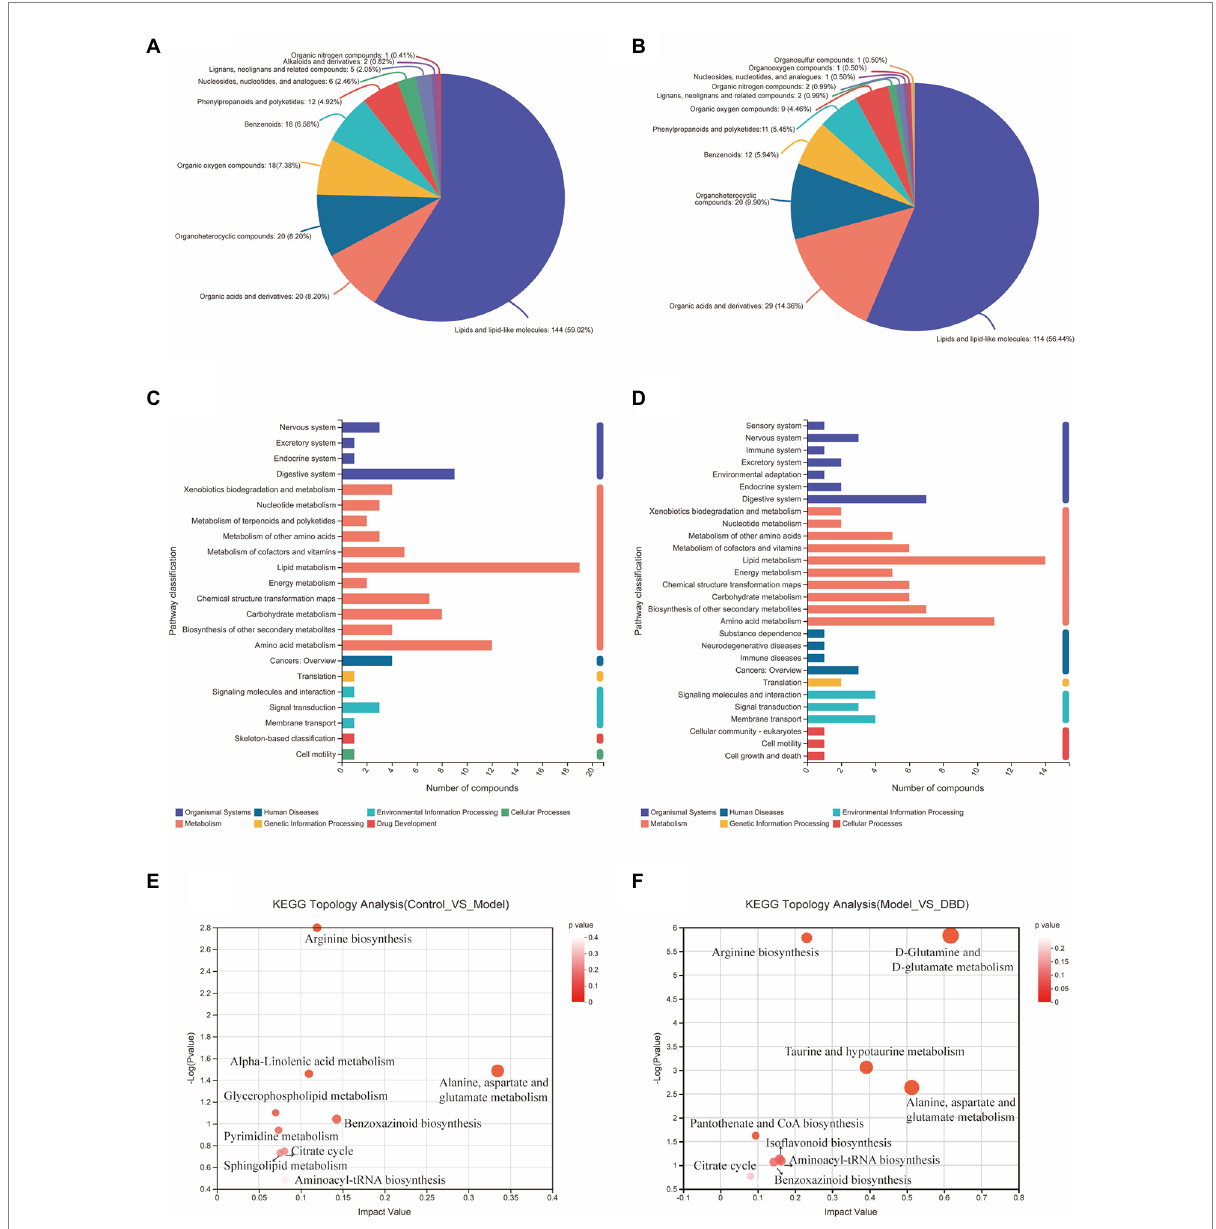
FIGURE 4 Summary of differential metabolite classification and related pathway analysis. (A) Classification of differential metabolite between control and model group in Superclass of HMDB level. (B) Classification of differential metabolite between model and DBD group in Superclass of HMDB level. (C) Numbers of differential metabolite in different KEGG pathways between control and model group. (D) Numbers of differential metabolite in different KEGG pathways between model and DBD group. (E) KEGG topology analysis bubble plot between control and model group. (F) KEGG topology analysis bubble plot between model and DBD group. Each bubble in the Figure represents a KEGG pathway. The horizontal axis represents the impact value of metabolites in the pathway and the vertical axis represents the enrichment significance of metabolites in the pathway -Log 10 ( p value). Bubble size represents impact value and the larger the bubble, the more important the pathway